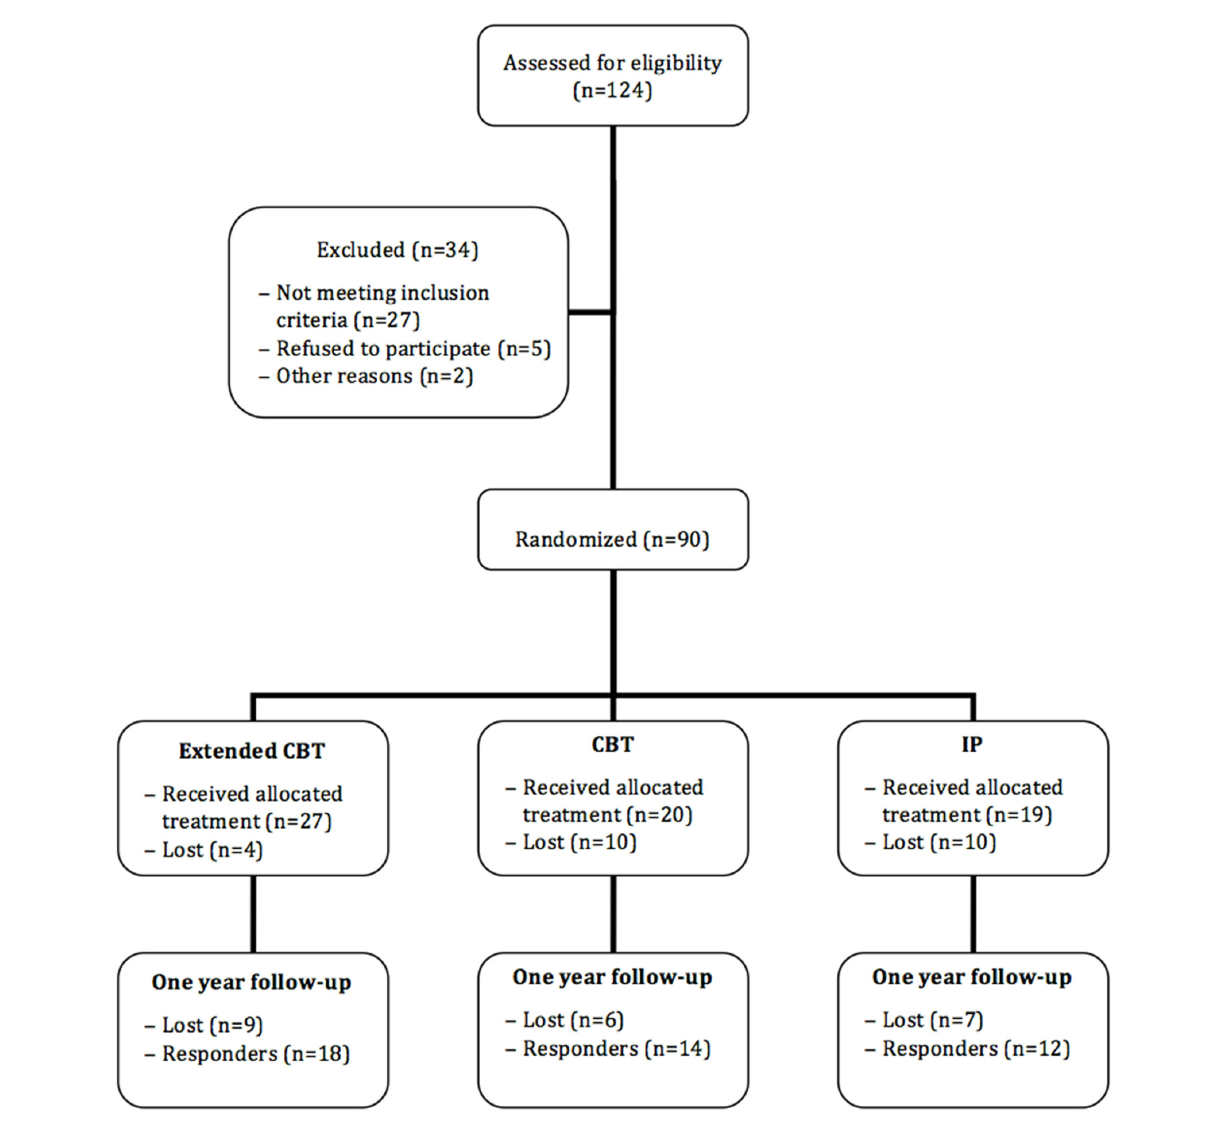
Figure 1. Clinical trial